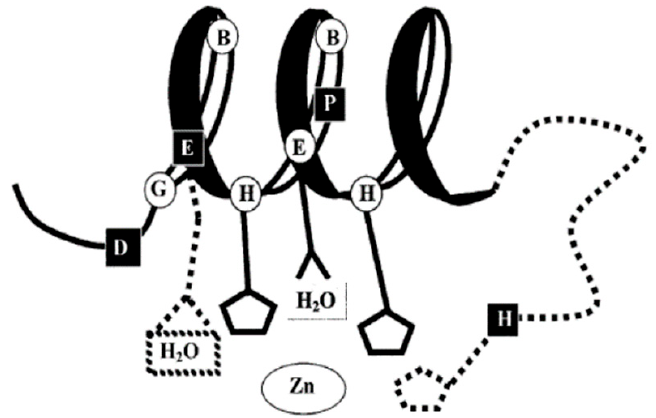
Figure 4. A schematic diagram of the zinc-binding environment of the metzincins has been altered to suggest the potential zinc-coordinating residues in the LIV-1 family. Residues shaded in black are known to coordinate zinc, square boxes represent conserved residues unique to the LIV-1 family, and dotted lines suggest the zinc-coordination ability. Figure taken from